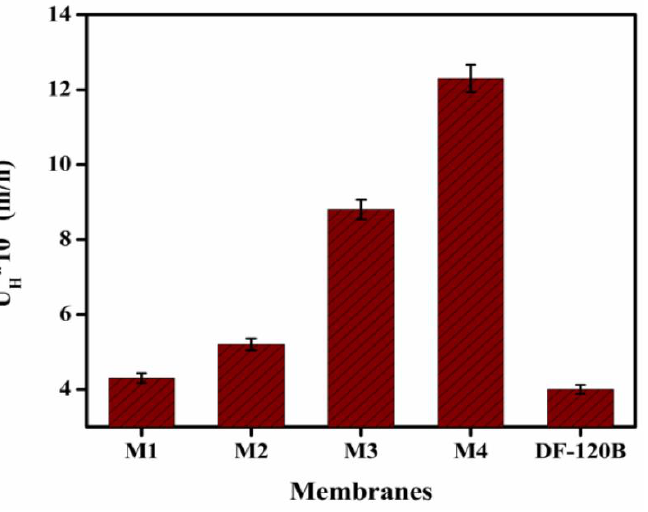
Figure 13. Acid dialysis coefficient ( U H ) at 25 °C for different representative porous BPPO-based membranes.